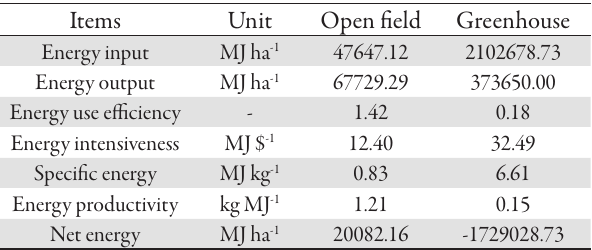
Tab. 7. Tomato production energy indices in open field and greenhouse